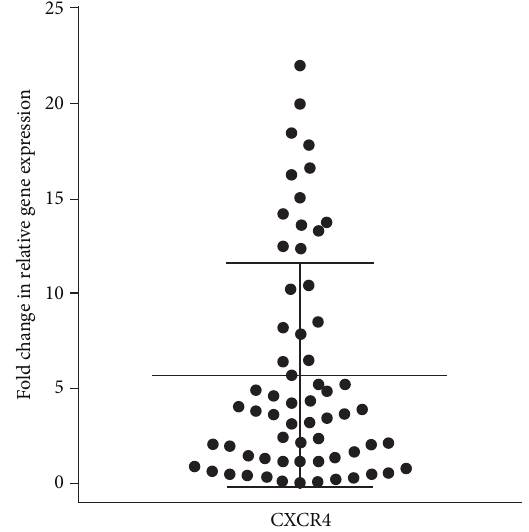
Figure 2: CXCR4 gene expression in tumor samples. Relative gene expression was performed by quantitative PCR using 2 −ΔΔ CT method, in relation to mRNA from tumor-adjacent tissue and to normal mammary gland. Mean fold change = 5.7 ( 𝑝 < 0.0001 ).